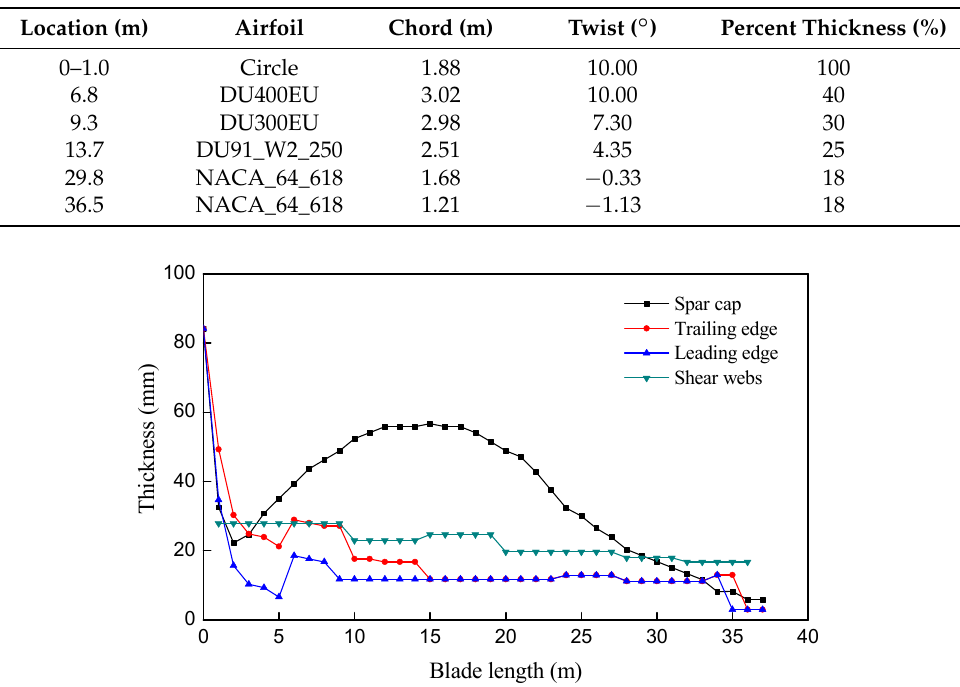
Table 2. The main geometrical features of the commercial 1.5 MW blade.